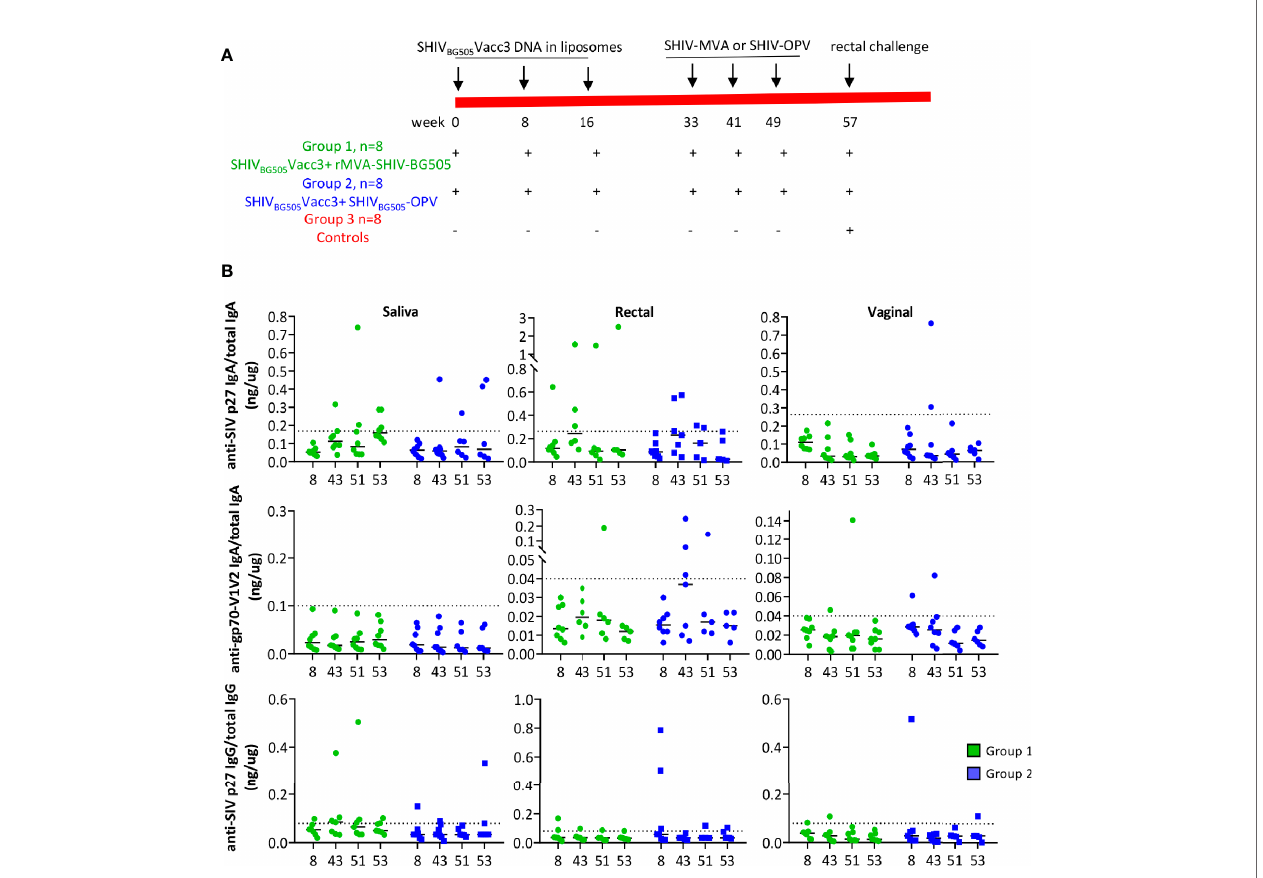
FIGURE 2 | (A) Vaccination scheme and animal groups. (B) Levels of anti-SIV p27 IgA (top 3 panels), anti-gp70-V1V2 IgA (middle panels) and anti-SIV p27 IgG in saliva (left column), rectal (middle column), and vaginal secretions (right column) were measured by BAMA and normalized relative to concentrations of total IgA or IgG, determined by ELISA. The speci fi c activity (ng IgA or IgG antibody/µg total IgA or IgG, respectively) for individual animals at four time points during vaccination is reported. The dashed line denotes the cut-off for signi fi cance and was calculated as the mean speci fi c activity + 3 SD for pre-immunization samples. The speci fi c activity had to exceed the dotted line and be 3 times higher than the animal ’ s pre-immune sample to be considered signi fi cant. A few samples with insuf fi cient total IgA or IgG were not tested for SHIV-speci fi c